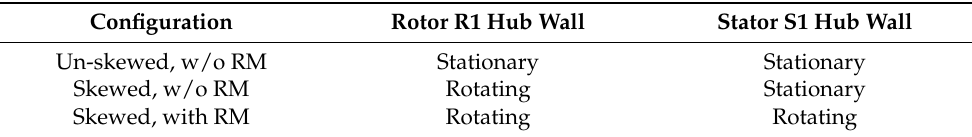
Table 2. Configurations of varying wall speed for test setup